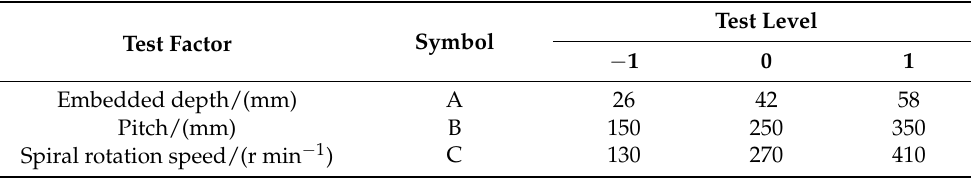
Table 3. Experimental factors